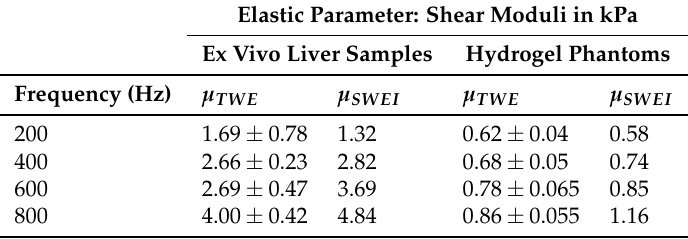
Table 4. Shear moduli in kPa for both ex vivo liver samples and hydrogel phantoms obtained from torsional wave elastography (TWE) and shear wave elastography imaging (SWEI) techniques. Elastic Parameter: Shear Moduli in kPa Ex Vivo Liver Samples